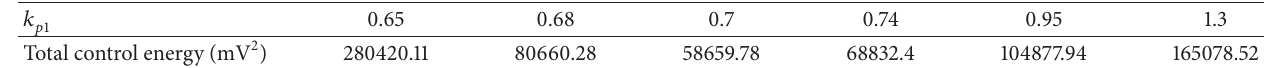
Table 3: The total control energy over 20 simulation realizations for different values of 𝑘 𝑝1